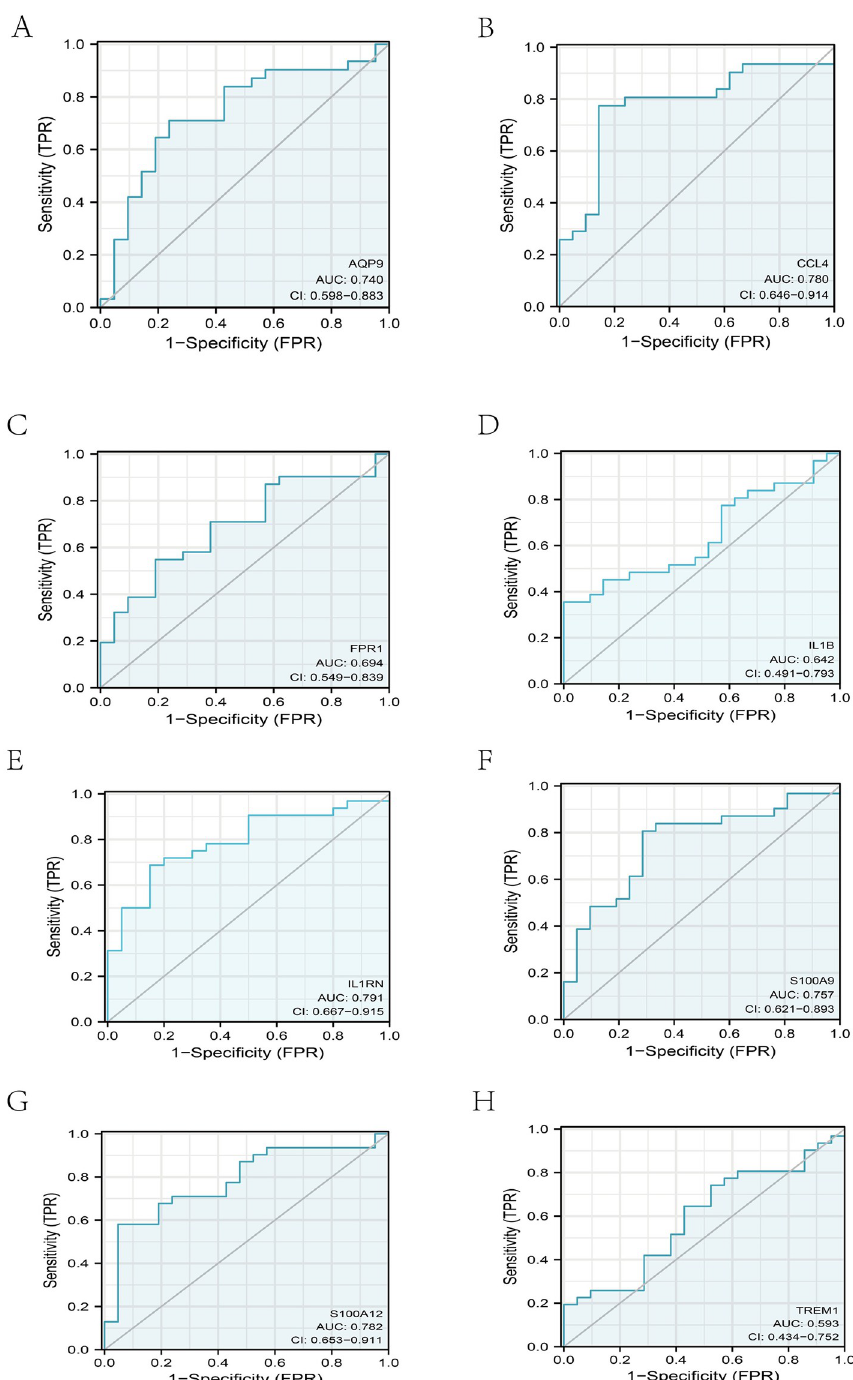
Fig 5. ROC plot. Gene expression ROC curve for the eight immune system-specific hub genes. AUC: the surface area under the ROC curve A. ROC plot of AQP9 . B. ROC plot of CCL4 . C. ROC plot of FPR1 . D. ROC plot of IL1B . E. ROC plot of IL1RN . F. ROC plot of S100A9 . G. ROC plot of S100A12 . H. ROC plot of TREM1 .